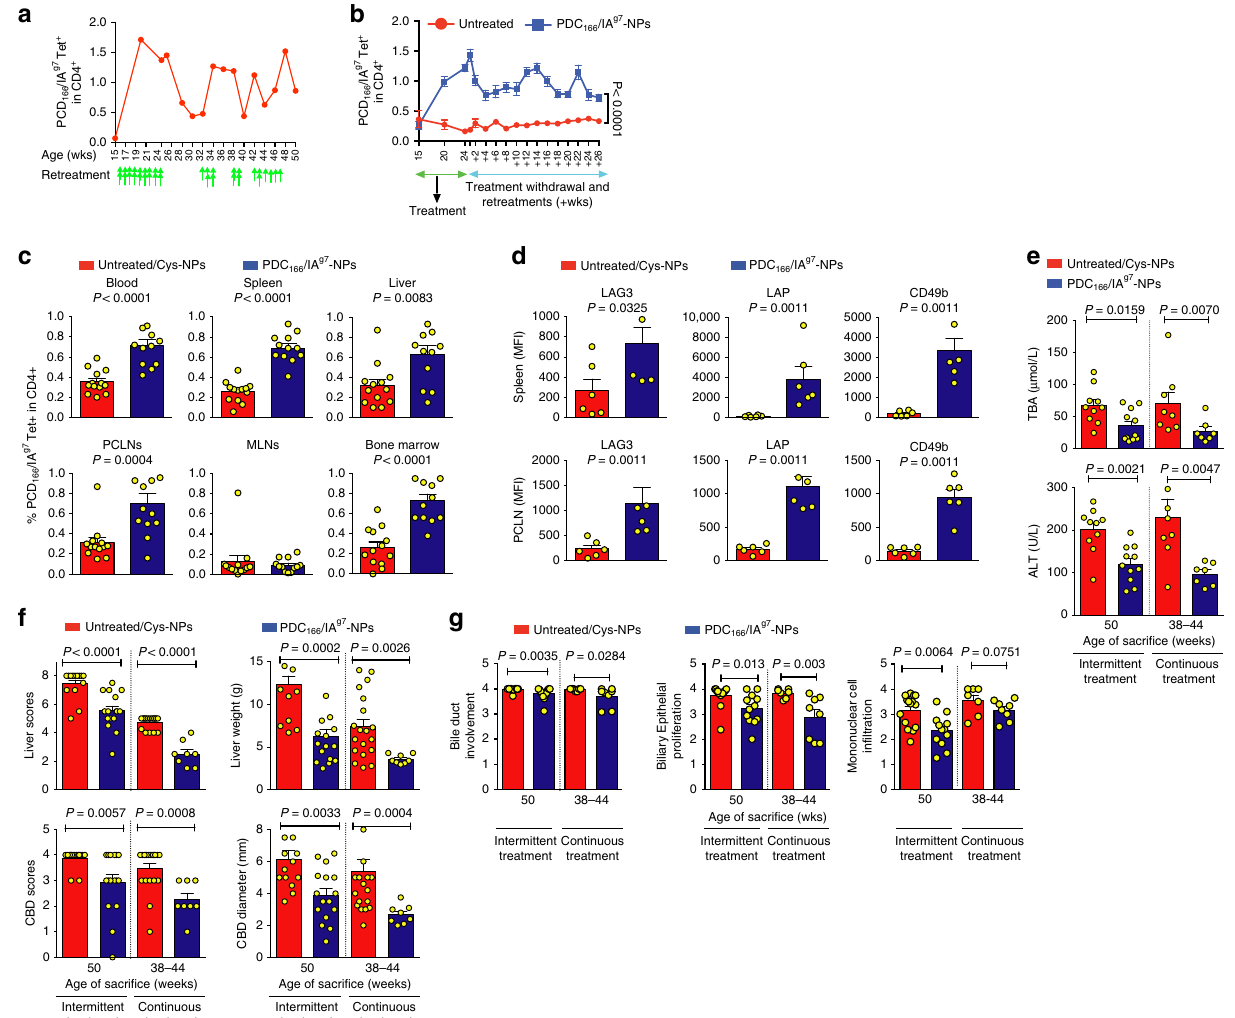
Fig. 6 Effects of intermittent vs. continuous therapy. a and b Changes in the circulating frequency of tetramer + CD4 + T-cells in response to intermittent re- treatment (as a function of circulating tetramer + T-cell levels). a shows pro fi les of one mouse, where the green arrows indicate the timing of individual doses and double arrowheads indicate that two doses were given in that particular week(s). Treatment was withdrawn at 24 weeks of age. Mice were monitored for persistence of tetramer + cells in blood once every two weeks. When the percentages of tetramer + cells fell below 50% of the original values, treatment was re-initiated and when the percentages of tetramer + cells in blood recovered, treatment was withdrawn again. b shows the average values ± SEM corresponding to cohorts of NOD. c3c4 mice intermittently treated with PDC 166 – 181 /IA g7 -NPs ( n = 19) or left untreated ( n = 16) after withdrawal of continued therapy (twice a week from 15 to 24 weeks of age). Data are from four experiments. c and d Percentage of tetramer + CD4 + T-cells and mean fl uorescence intensity staining for TR1 markers in tetramer + CD4 + T-cells from the mice studied in a and b . Data in c correspond to n = 12 pMHCII-NP-treated and 13 untreated mice/organ, respectively, from four experiments. Data in d correspond to n = 6 mice/group/organ. e – g Serum TBA and ALT levels ( e ; n = 10, 11, 8 and 7, from left to right, respectively), macroscopic ( f; n = 14, 16, 19, and 8, from left to right, respectively) and microscopic ( g; n = 15, 12, 7, and 8 from left to right, respectively) scores from mice treated intermittently (from 15 to 50 weeks of age), or continuously (twice a week from 24 to 38 – 44 weeks of age). Averaged data correspond the mean ± SEM. P values were compared via Mann – Whitney U ( c – g ) or two-way ANOVA ( b